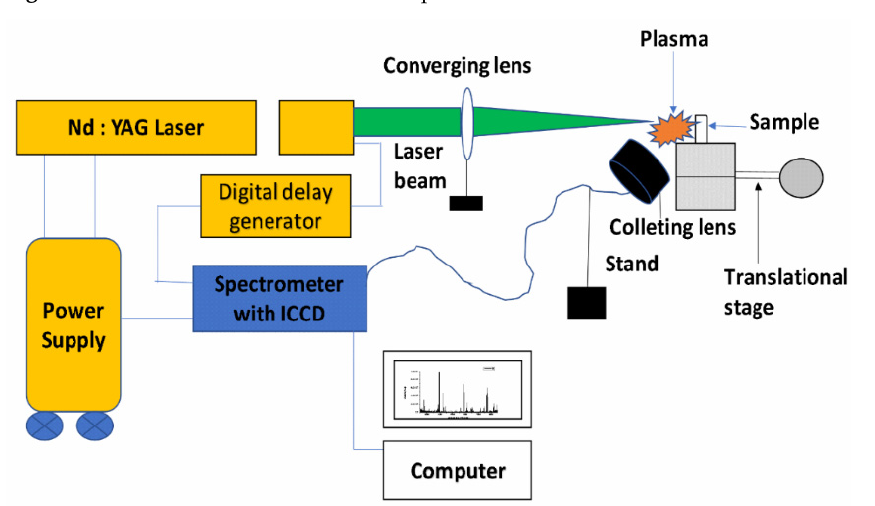
Figure 13. Pellet of different turmeric samples.